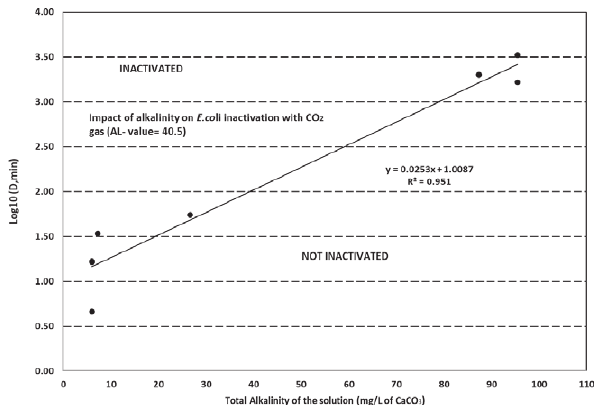
Figure 3. Minimum CO 2 and combustion gas bubbling times at dif- ferent alkalinity values to achieve 1-log bacteria inactivation in 6 different alkaline solutions. Above and to the right of the lines the pathogens will be sterilized by